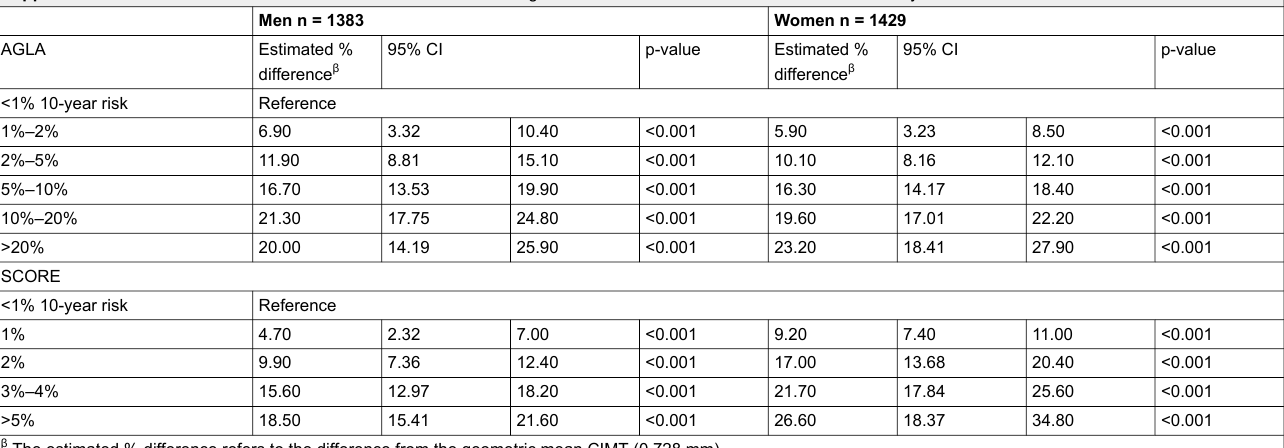
Supplemental table 2: Association of AGLA-1 and SCORE with average carotid intima media thickness in SAPALDIA 3 by sex. Men n =